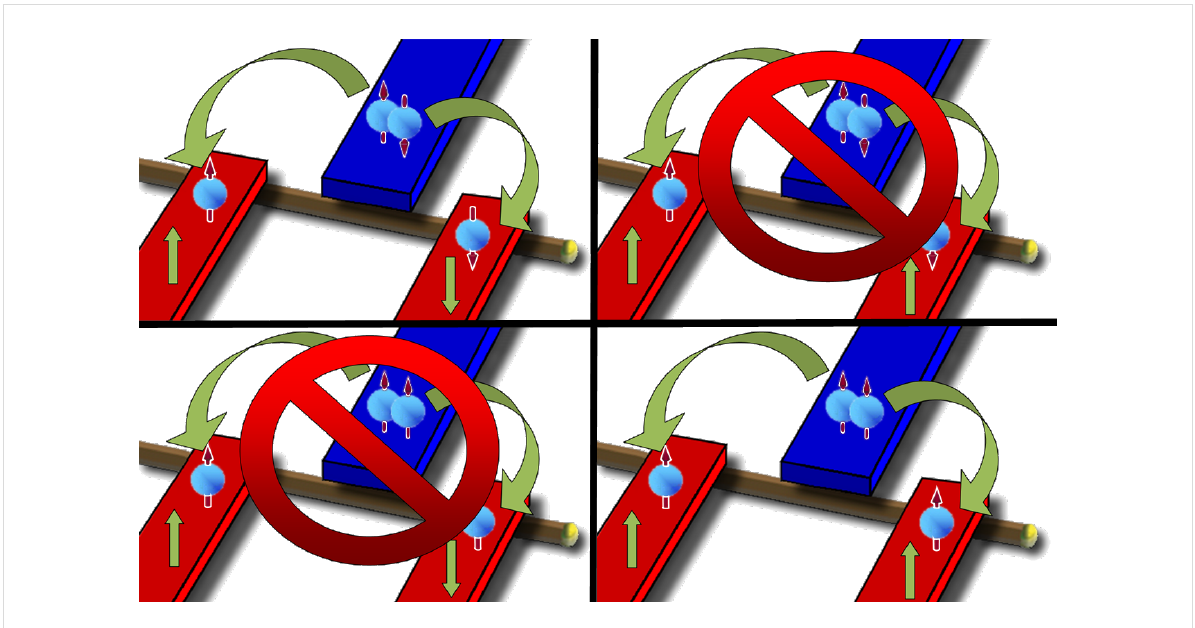
Figure 1: Summary of the possible charge-transfer processes in a superconductor–ferromagnet beam splitter. The superconductor (blue) and the two ferromagnets (red, assumed to be fully polarized) are coupled via a quantum dot, which is realized by an InAs nanowire (brown). The polarization is indicated by green arrows. In the upper part, the situation for s-wave superconductors is shown. The Cooper pair may split if the two ferromagnets are antiparallelly polarized. In the lower part the reversed situation for spin-polarized p-wave superconductors is depicted. The Cooper pair may now split only if the two ferromagnets are equally